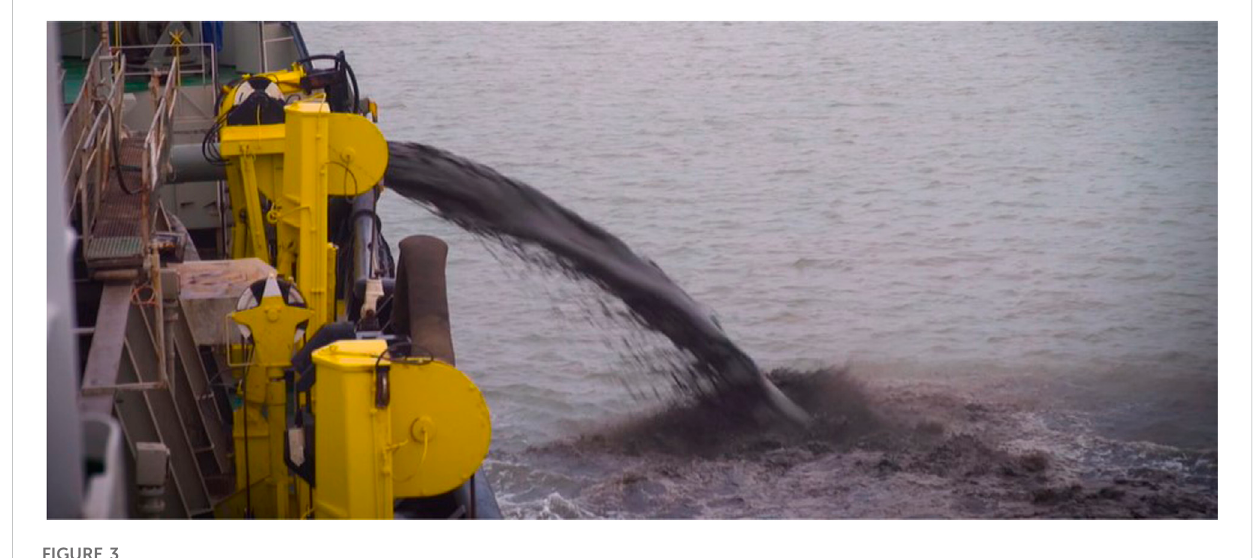
FIGURE 3 Water column recharge by